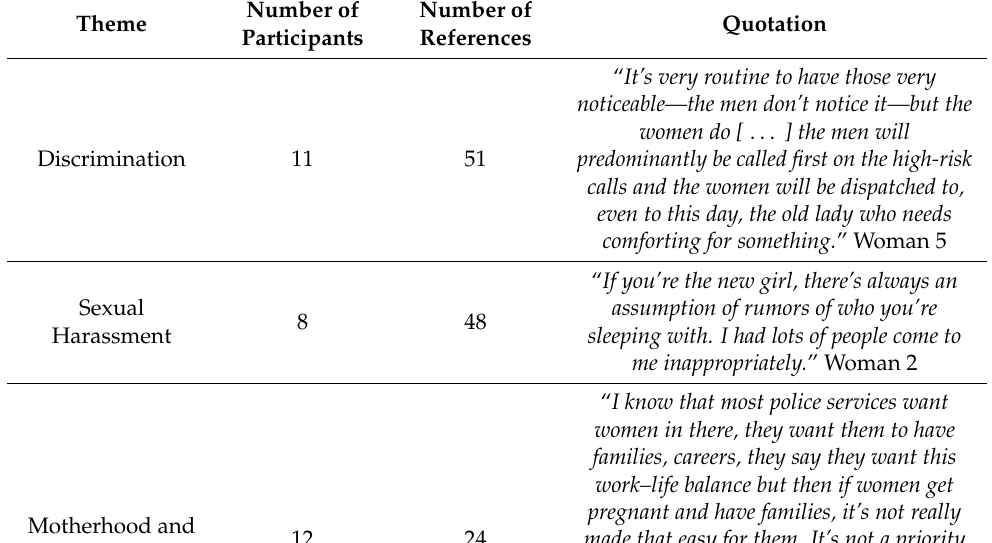
Table 1. Summary of themes and their